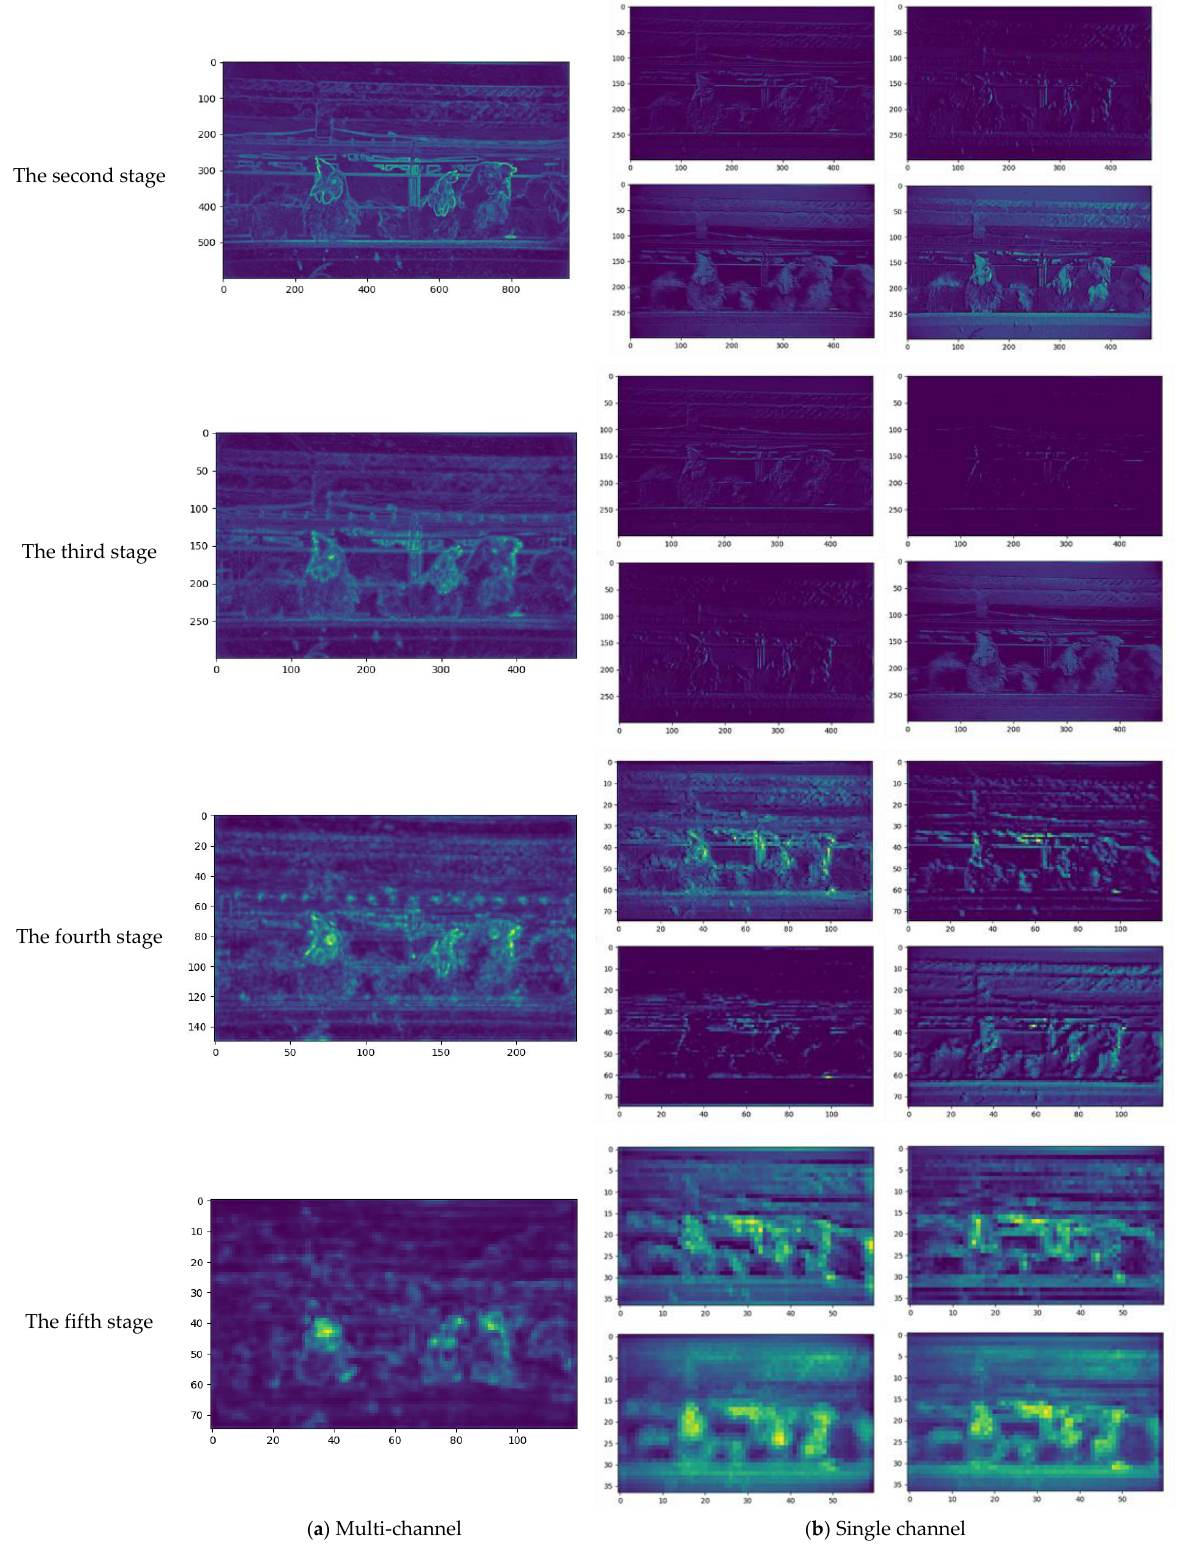
Figure 7. Feature maps from stage 2 to stage